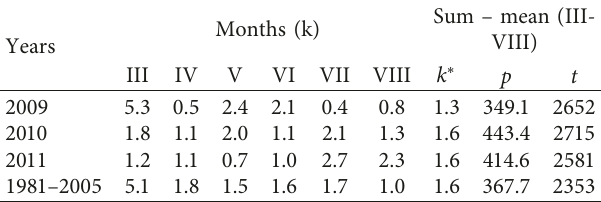
Table 4: Selyaninov’s hydrothermal coefficient, sum of pre- cipitation (mm), and mean air temperature ( ° C) in growing seasons (2009–2011), and the long-term averages from 1971 to 2005 (meteorological station in Zamo´s´c).